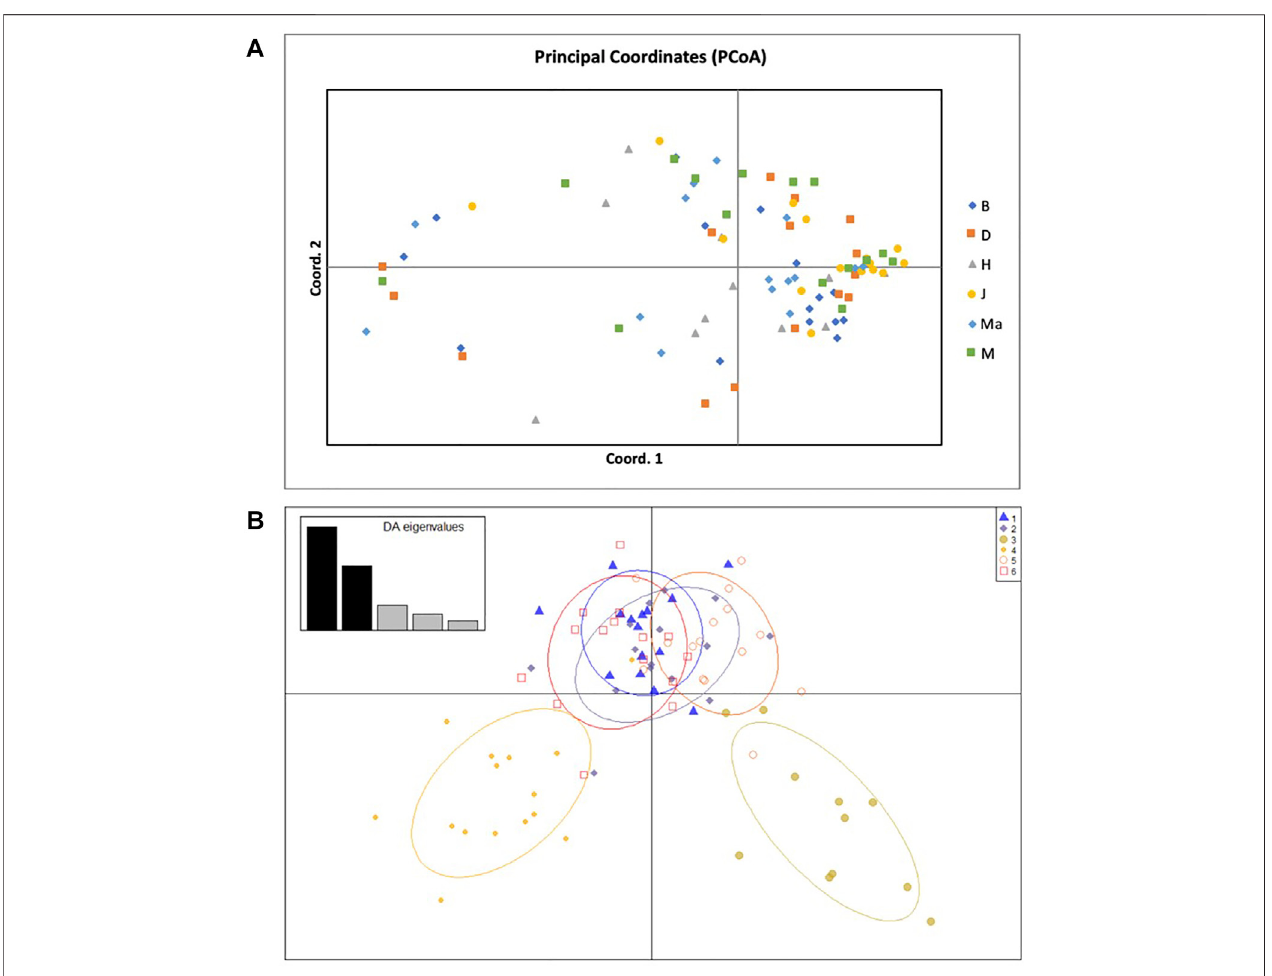
FIGURE 3 | (A) Principal Coordinate Analysis (PCoA) of 86 individuals across six wild rooibos populations based on 11 SSR loci. B — Blomfontein, D — Dobbelaarskop, H — Heuningvlei, J — Jamaka, Ma — Matarakopje, M — Melkkraal. (B) Discriminant Analysis of Principal Components (DAPC) analysis of 86 individuals across six wild rooibos populations based on 11 SSR loci. B — Blomfontein, D — Dobbelaarskop, H — Heuningvlei, J — Jamaka, Ma — Matarakopje, M — Melkkraal. Each grouping represents a genetic cluster.